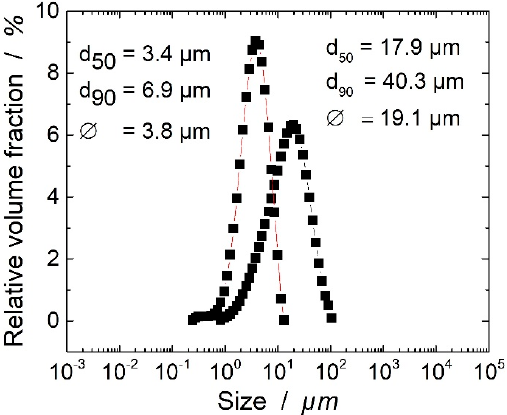
Figure 1. Particle size distribution of the used graphite types.